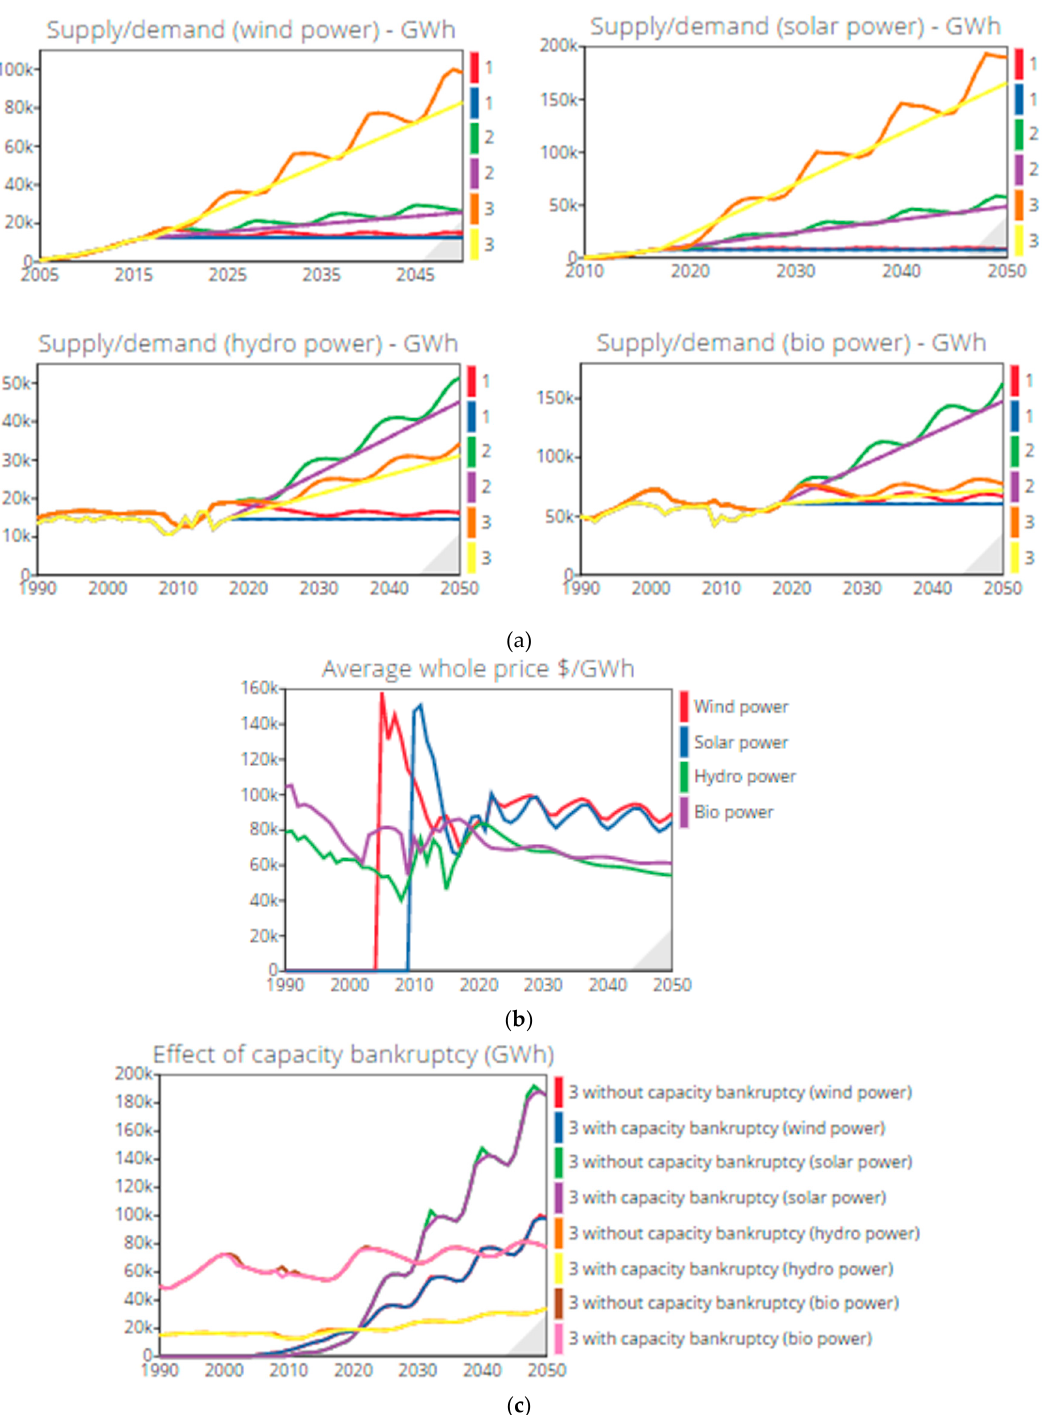
Figure 11. Behaviour over time produced by each development scenario until 2050 for ( a ) energy supply/demand, ( b ) average wholesale price and ( c ) bankruptcy. The numbers on each colour represent (1) no growth scenario, (2) base case/current scenario and (3) likely to happen scenario, as described in Table 1.